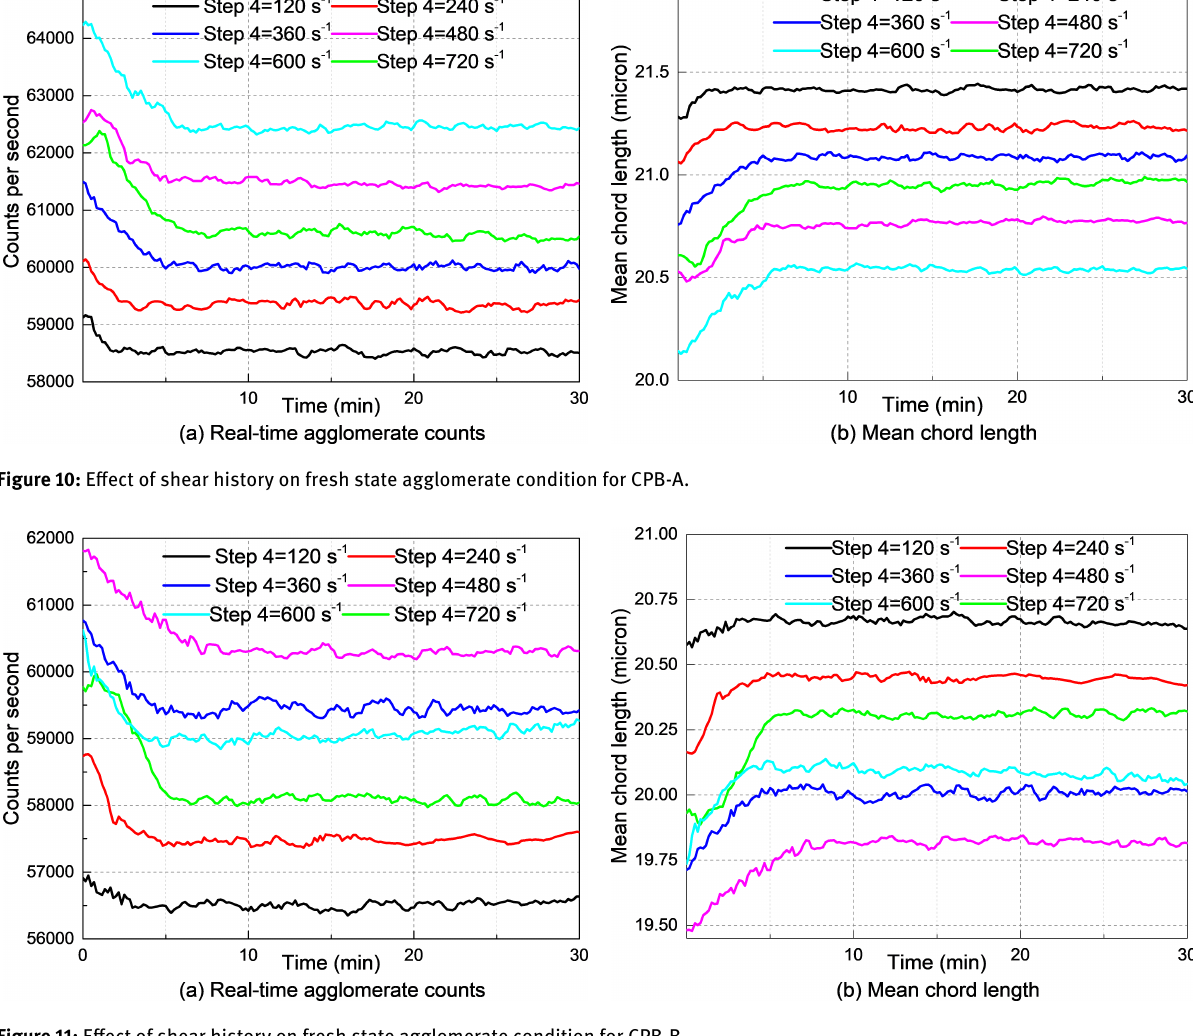
Figure 11: Effect of shear history on fresh state agglomerate condition for CPB-B. Table 5: Influence of shear history on the agglomeration